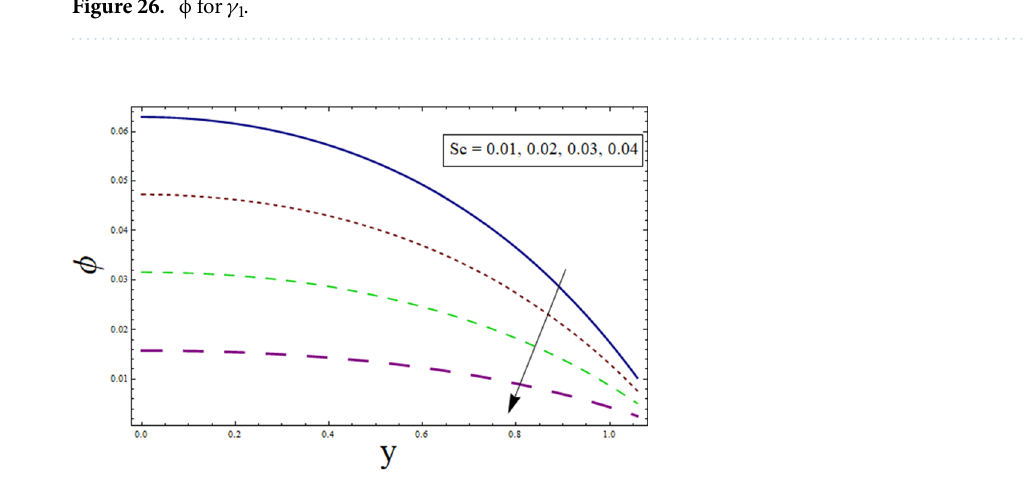
Figure 26. ϕ for γ 1 .